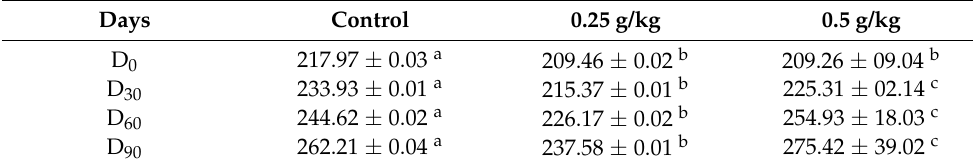
Table 8. Body weight changes in rats treated with O. basilicum